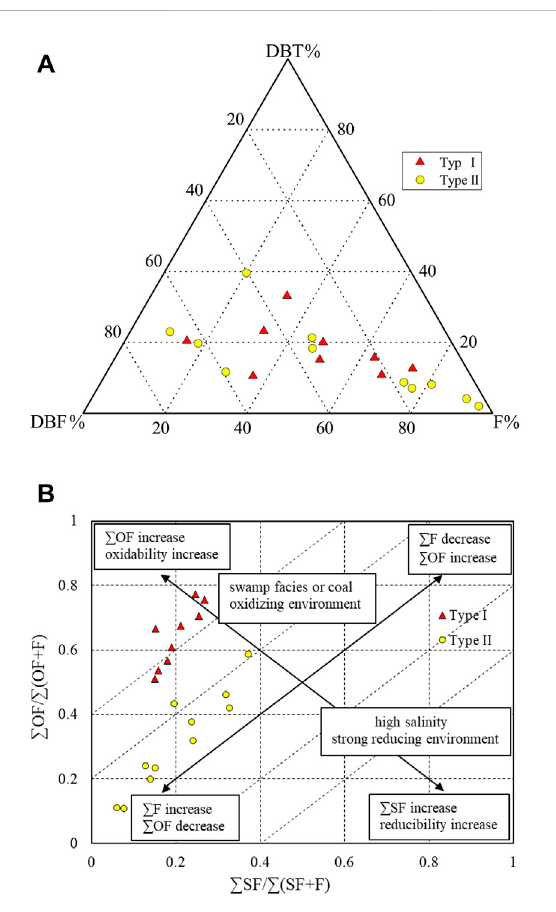
FIGURE 8 (A) Ternary diagram of DBT, F, and DBF of crude oil from the East Fukang Sag, (B) The correlation between (cid:1) OF/ (cid:1) (OF+F) and (cid:1) SF/ (cid:1) (SF+F)ofcrudeoil. (cid:1) F, (cid:1) OFand (cid:1)